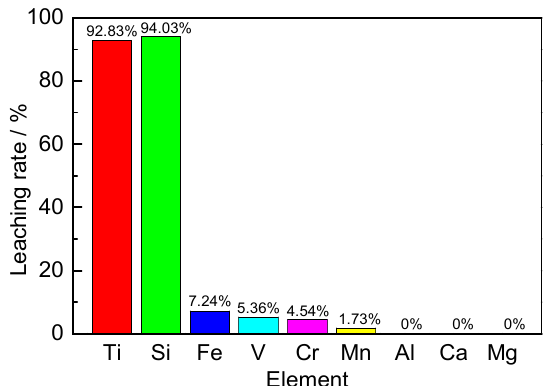
Figure 12. Leaching rates of elements in TEFS under the conditions of F − concentration at 14 mol/L, leaching temperature of 90 °C for 20 min with L / S ratio of 20:1, and rotating speed of 200 r/min.